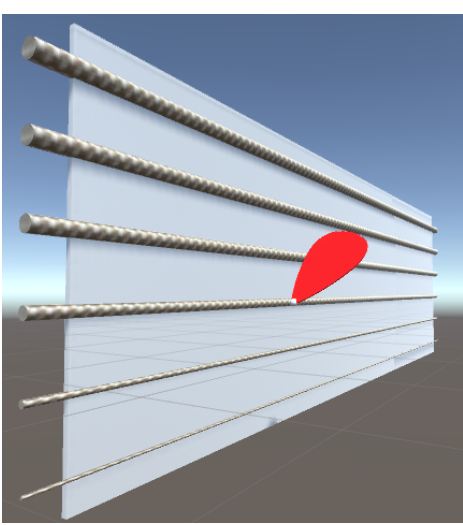
Figure 3. The haptic workspace in Keytar. The colliding sphere is visible as a white tip on the edge of the plectrum.